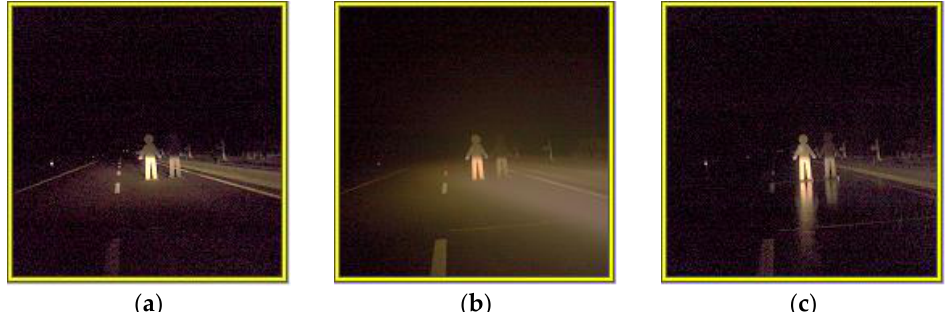
Figure 9. Examples of measurements in conditions of pedestrian target distance of 12.5 m and color temperature of 3000 K: ( a ) Clear condition; ( b ) fog condition with a visibility of 100 m; ( c ) rain condition with a rainfall of 20 mm/h.